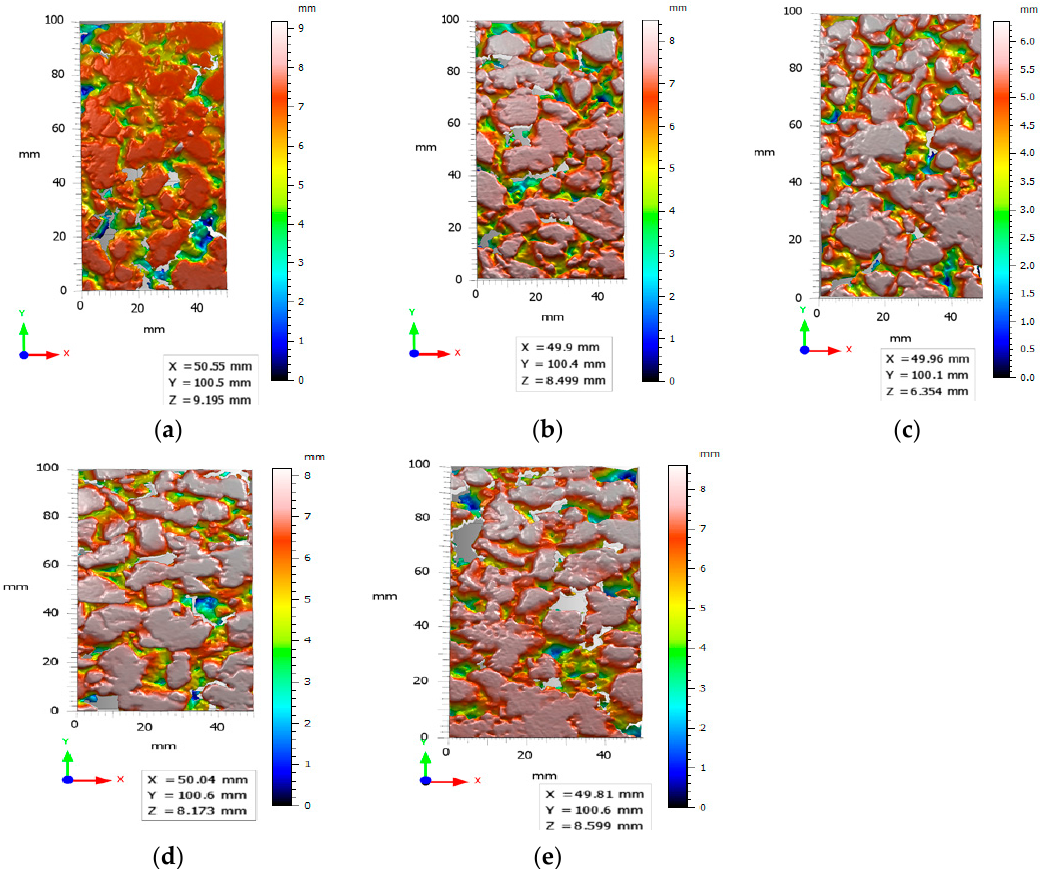
Figure 18. Surface 3D textures of several sets of measurement points. ( a ) Mp 1-1; ( b ) Mp 4-1; ( c ) Mp 6-1; ( d ) Mp 7-1; ( e ) Mp 7-2. ( c ) Mp 6-1; ( d ) Mp 7-1; ( e ) Mp